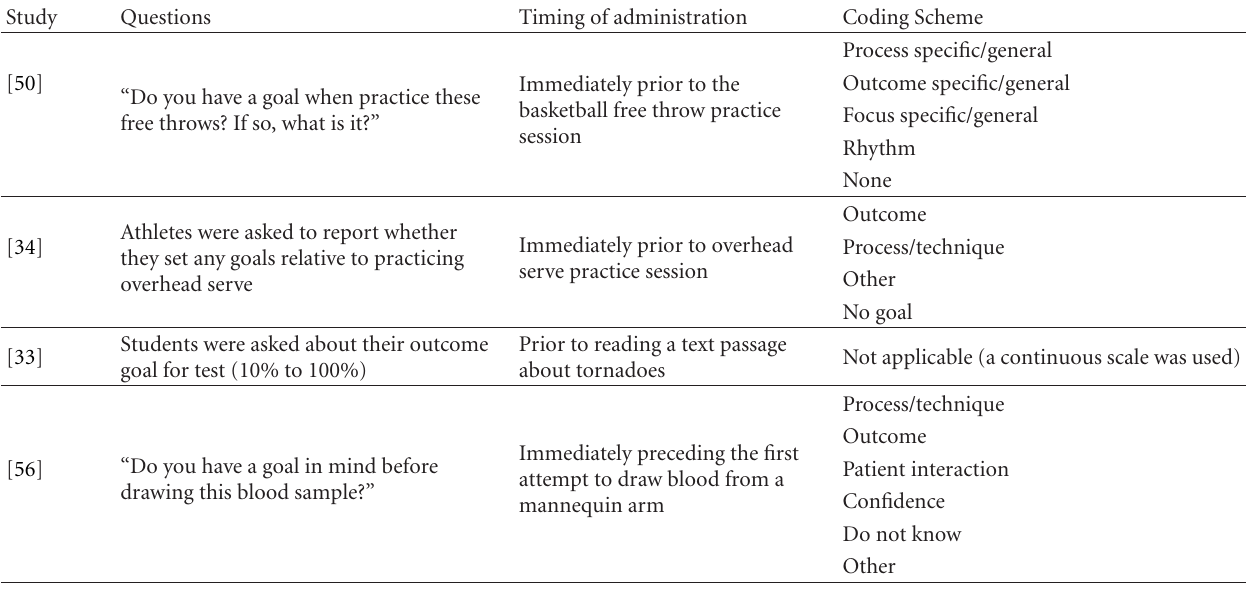
Table 2: Examples of goal-Setting microanalytic questions, coding schemes, and administration procedures. Study